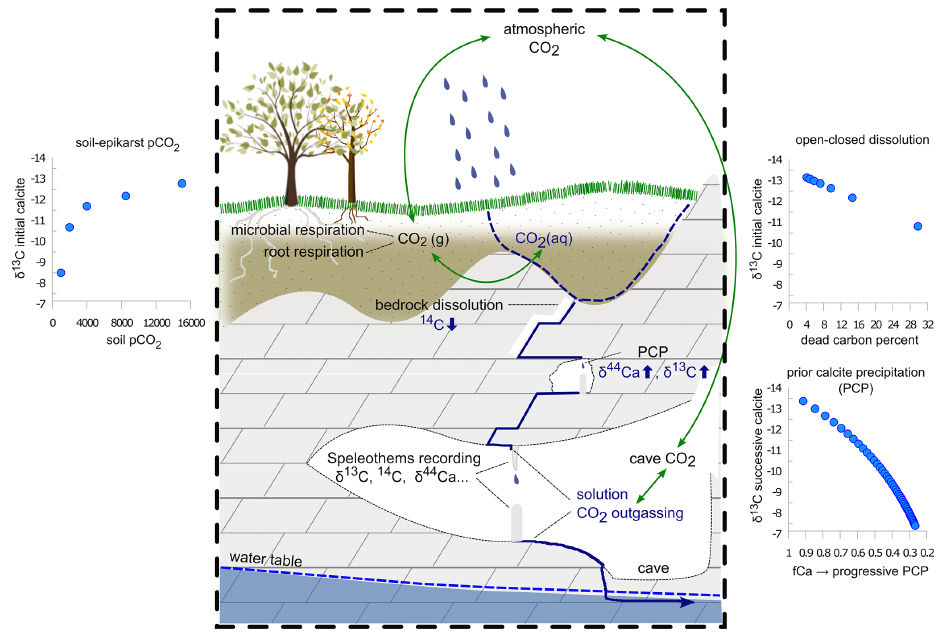
Figure 2. Schematic representation of the main processes modulating δ 13 C, δ 44 / 40 Ca, and 14 C in the soil–karst–cave system. The small inserts show the evolution of δ 13 C spel in response to changes in soil p CO 2 , DCF, and PCP. The dissolution process can be constrained using DCF, while PCP is constrained using δ 44 Ca. Soil p CO 2 affects all three proxies but can be constrained further using the coupled relationship with δ 13 C from the mixing lines. Adapted from Day et al.